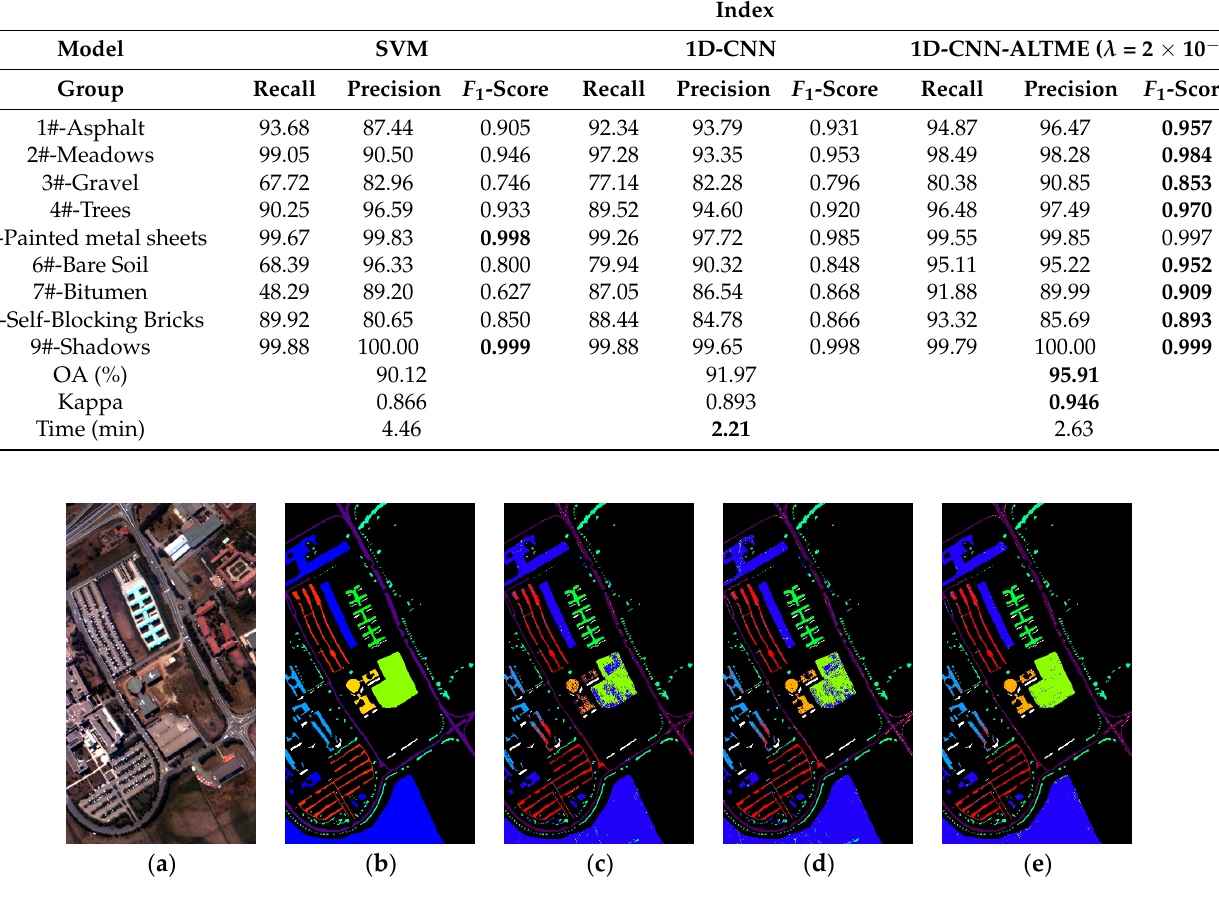
Figure 18. Recognition results for the public hyperspectral remote sensing data of Pavia University. ( a ) True color image (red: 50 band, green: 23 band, and blue: 5 band). ( b ) Sample labels. ( c ) Results of SVM. ( d ) Results of the 1D-CNN. ( e ) Results of 1D-CNN with the ALTME optimizer.